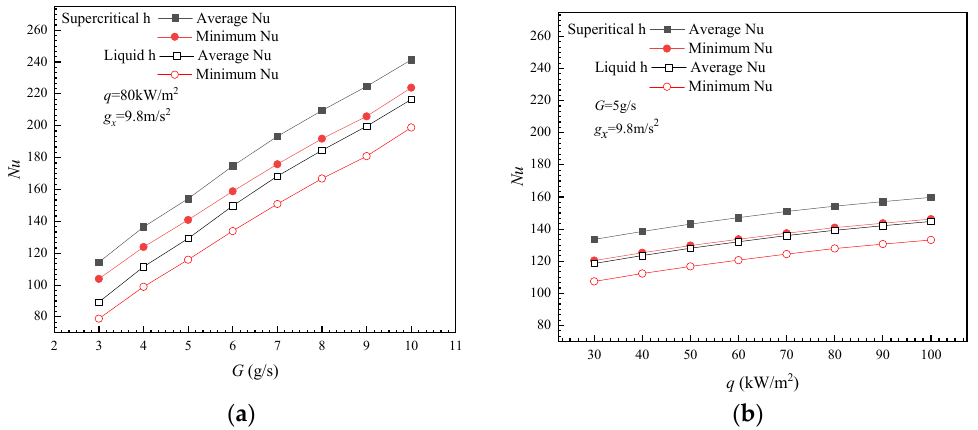
Figure 9. Comparison of average Nu and minimum Nu of supercritical and traditional liquid hedrogen under different conditions of G and q ( a , b ).